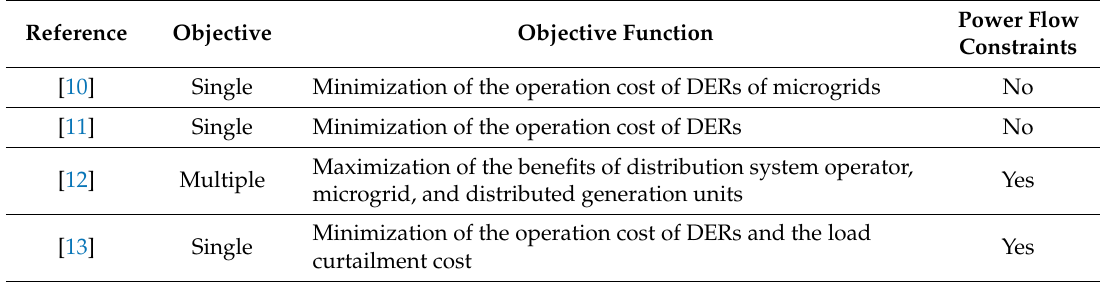
Table 2. Taxonomy of the reviewed optimization